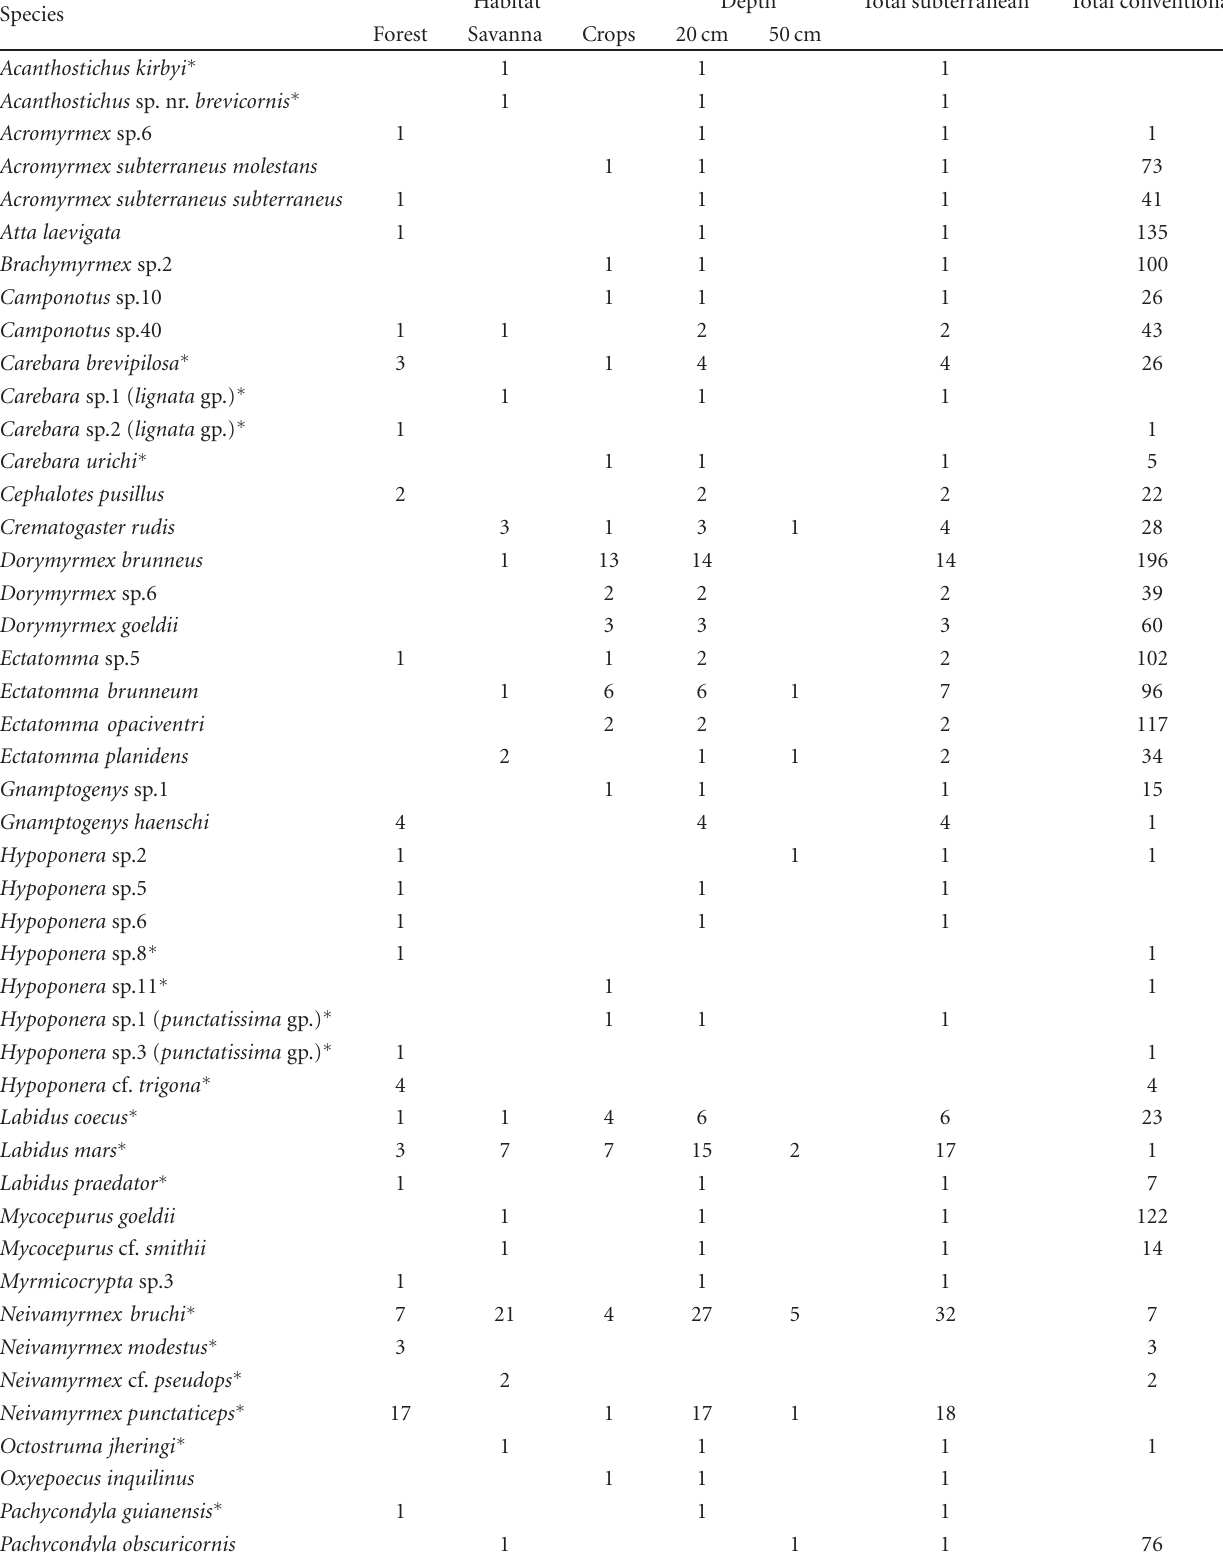
Table 2: List of all ant species collected with subterranean pitfall traps and list of all cryptobiotic species (marked with an asterisk) found during the study. Shown is the number of records (i.e., number of traps in which the species was present) of each species in di ff erent habitats, soil depths, and in total. The total number of records for each species in the conventional traps is also provided. Habitat Depth Total subterranean Total conventional Species Forest